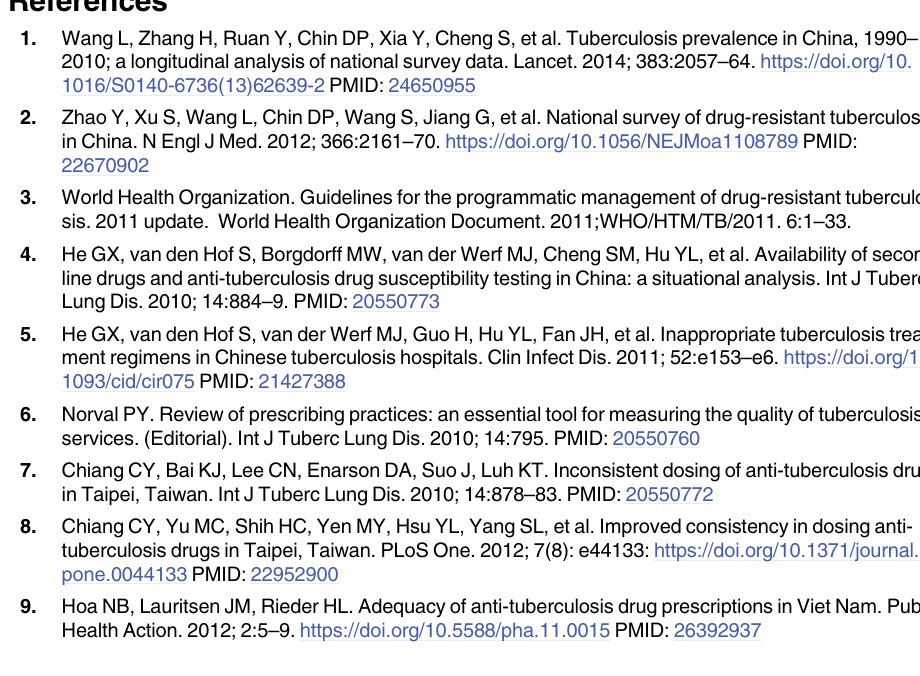
S1 Table. Recommended dosages of anti-tuberculosis drugs, according to China national tuberculosis programme (by body weight) and WHO